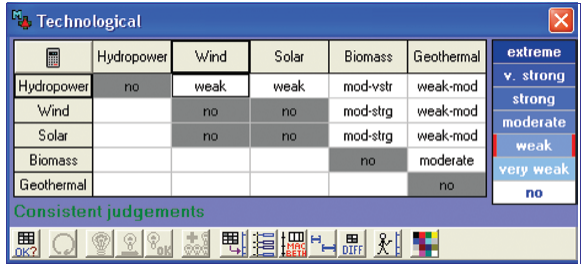
Fig. 3. Pairwise comparisons for renewable energy alternatives in maCBETh